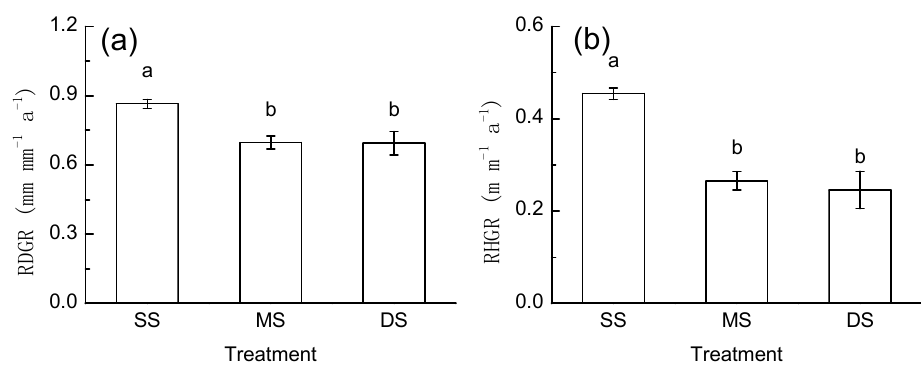
Figure 5. Relative diameter growth rate (RDGR) ( a ) and relative height growth rate (RHGR) ( b ) of S. matsudana under shallow submergence (SS), moderate submergence (MS) and deep submergence (DS) treatment in the hydro-fluctuation zone of the TGDR. Different letters on each bar represent significant difference among treatments at the 0.05 level. Values are means ± standard error ( n = 9).